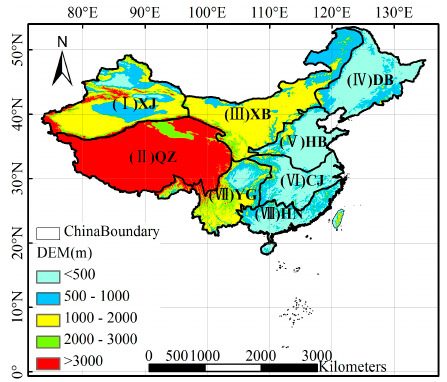
Figure 1. Distribution of sub-regions in China.